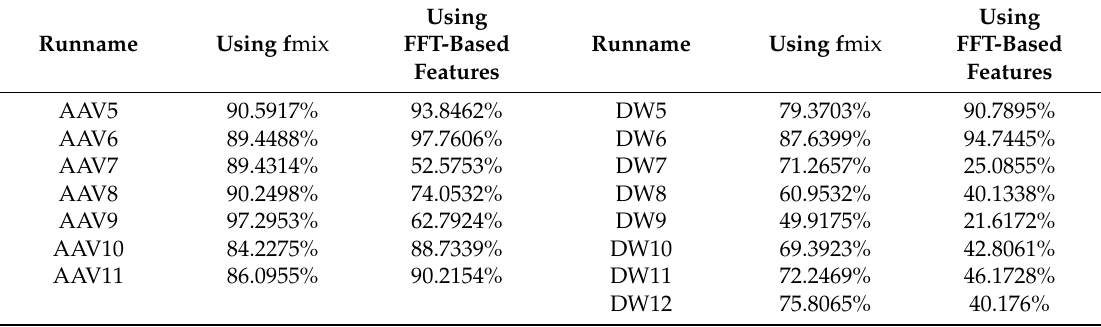
Table 7. Comparison of classification accuracy of different feature extraction methods.